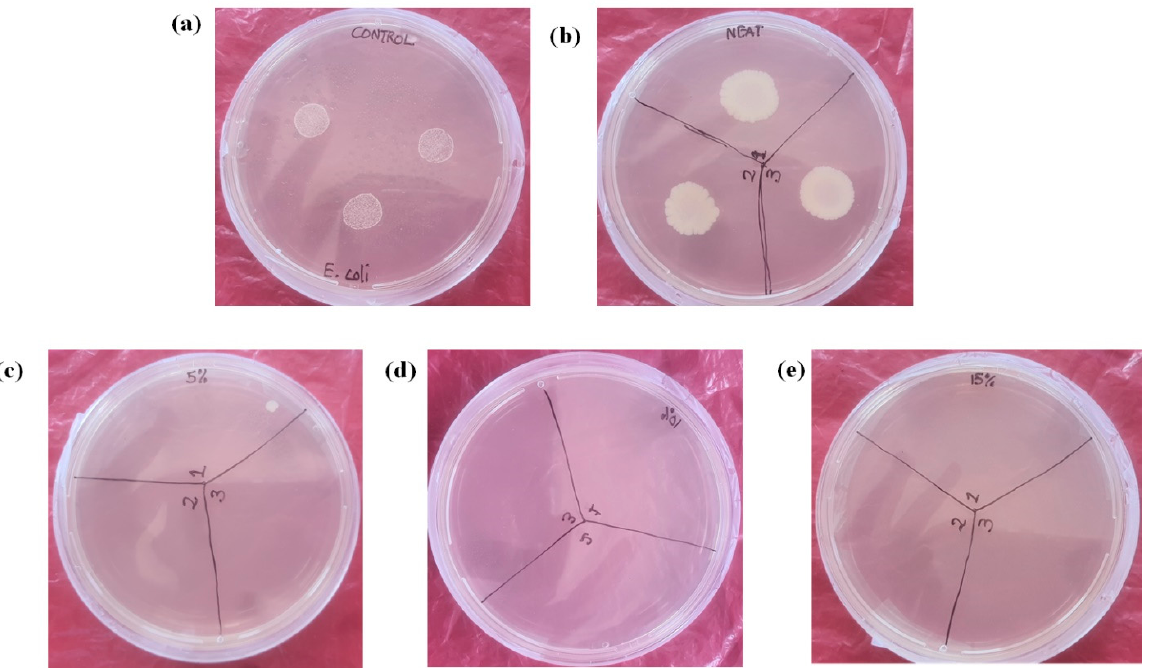
Figure 7. Images of petri dishes of the antimicrobial tests on various samples: ( a ) control, ( b ) blend, ( c ) blend reinforced with 5 wt.% lignin, ( d ) blend reinforced with 10 wt.% lignin, and ( e ) blend reinforced with 15 wt.% lignin.